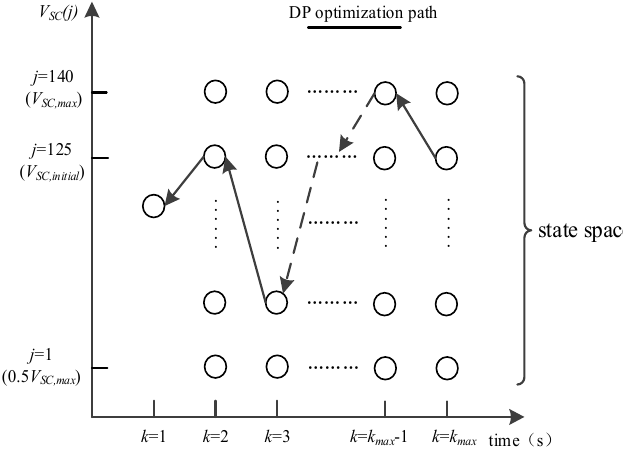
Figure 12. Dynamic programming (DP) approach flowchart. 305